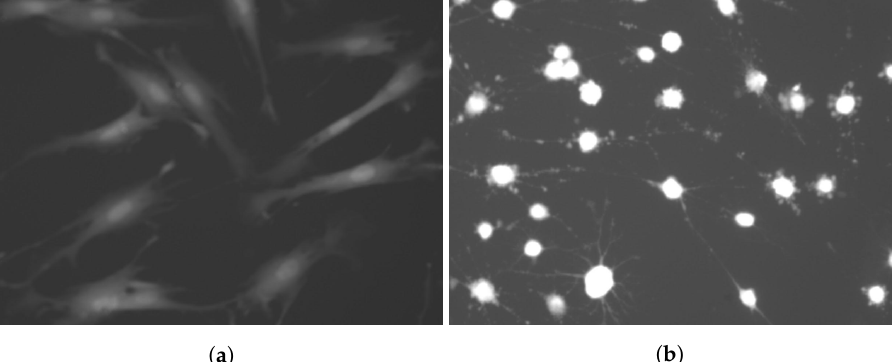
Figure 1. Green fluorescent protein (GFP) staining used to observe morphological features: ( a ) shows living cells, ( b ) dead ones.